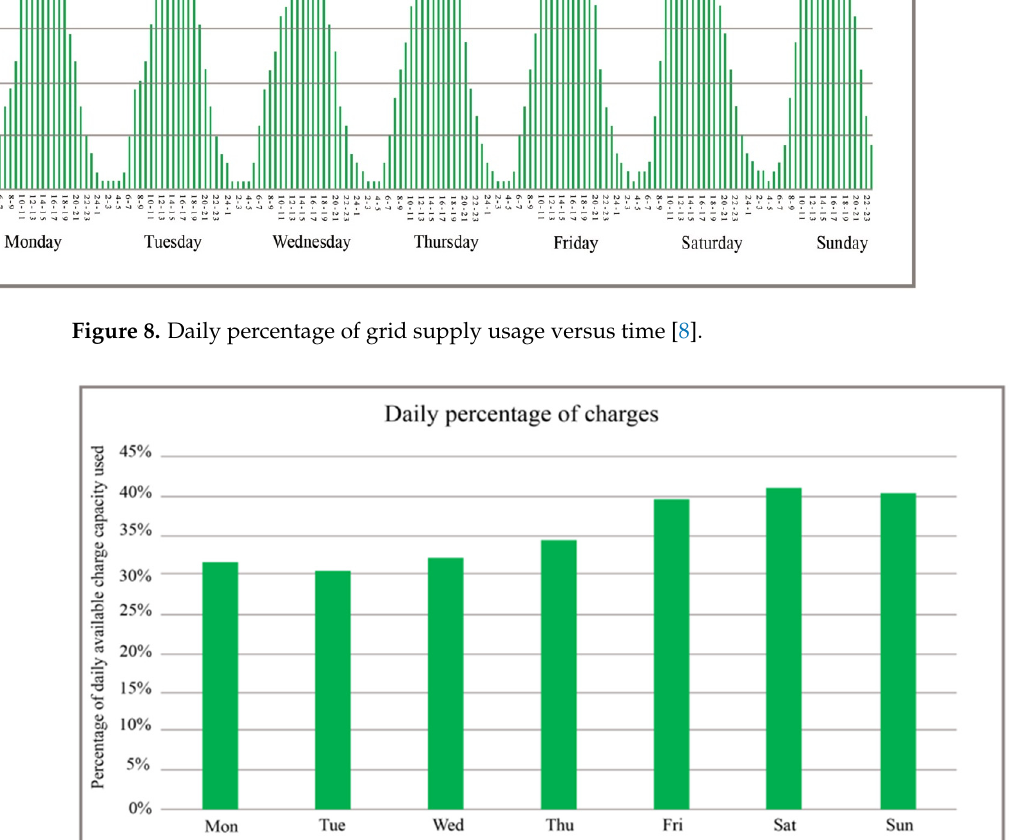
Figure 9. Charging activity shown as a percentage per day.